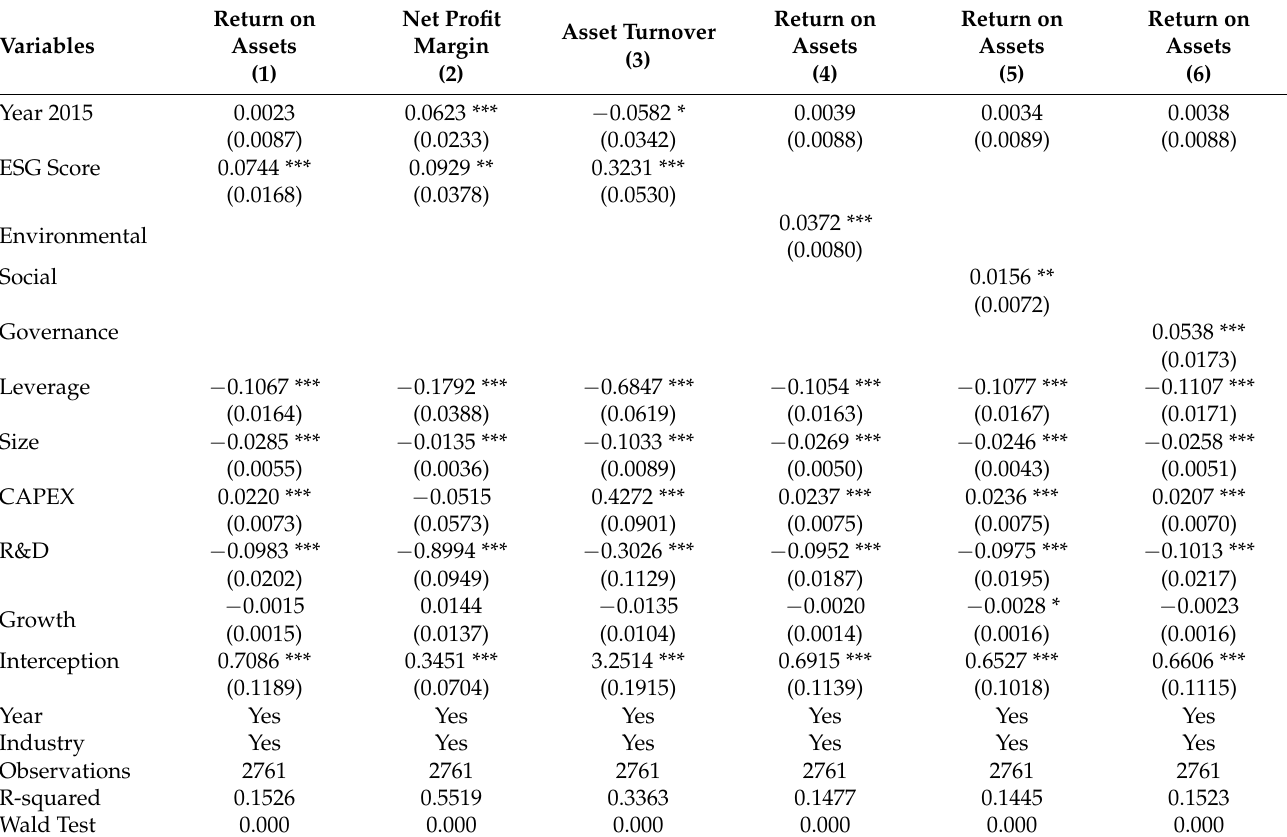
Table 9. OLS regressions: robustness analysis for